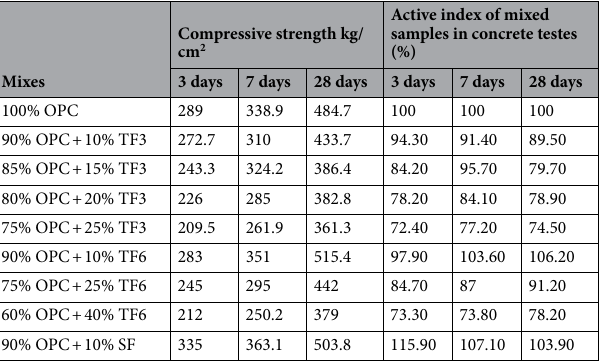
Table 10. Pozzolanic activity indexes and compressive strengths of OPC, Tuff and SF samples in